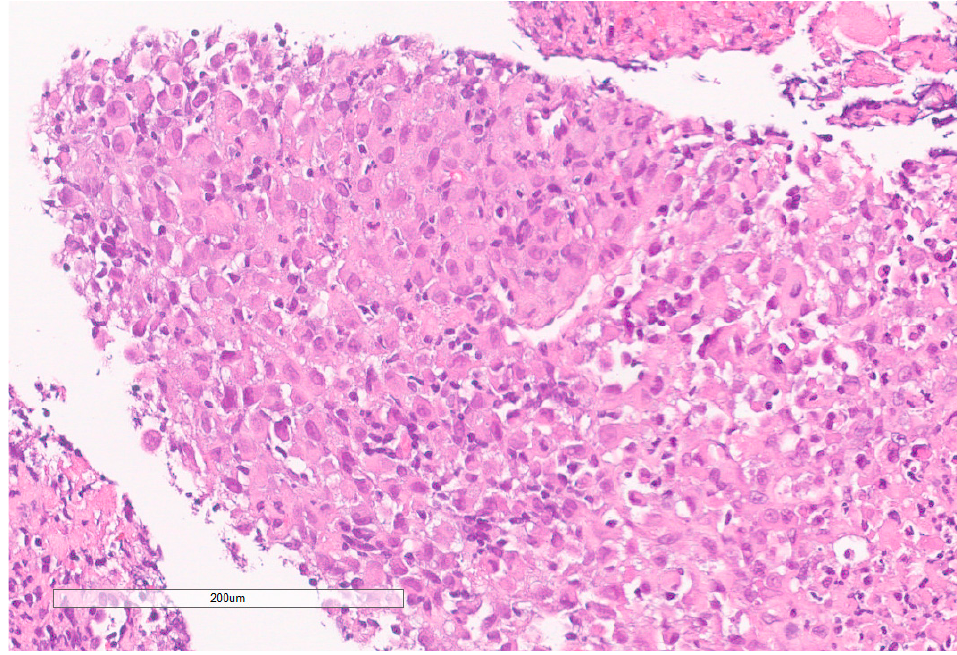
Figure 7. High grade carcinoma with necrosis; tumor cells have a rhabdoid morphology.